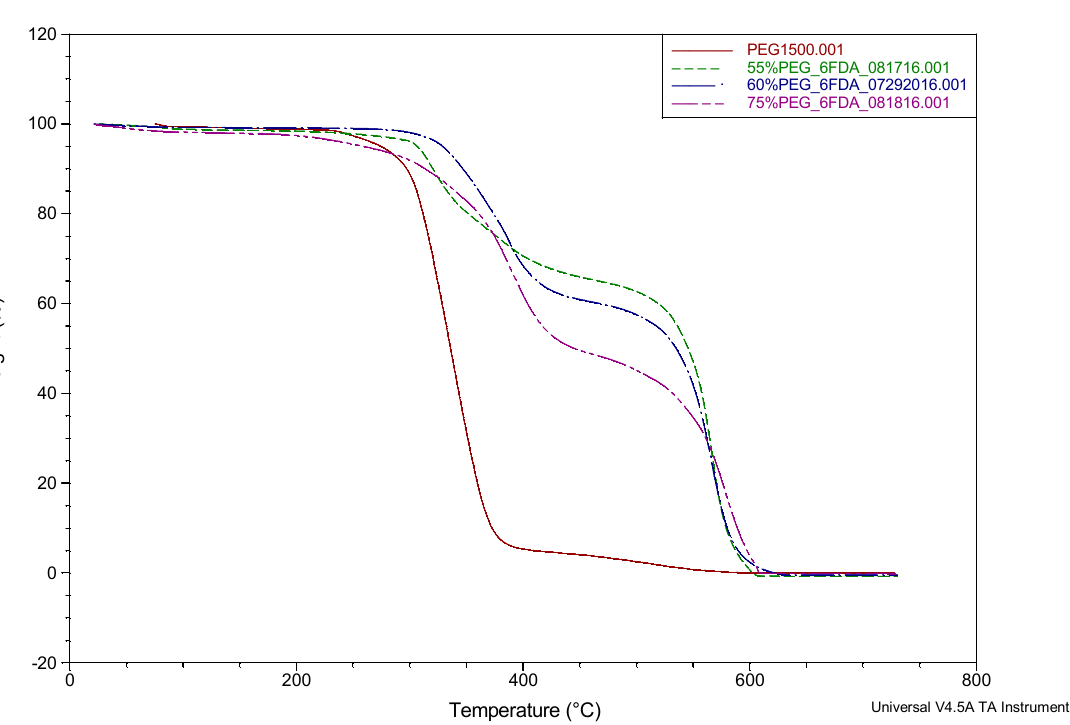
Figure 1. TGA of 6FDA-PDODA-PEG1500 (changing PEG content) SBC membranes (percentages given in the figure for PEG content are mol%).